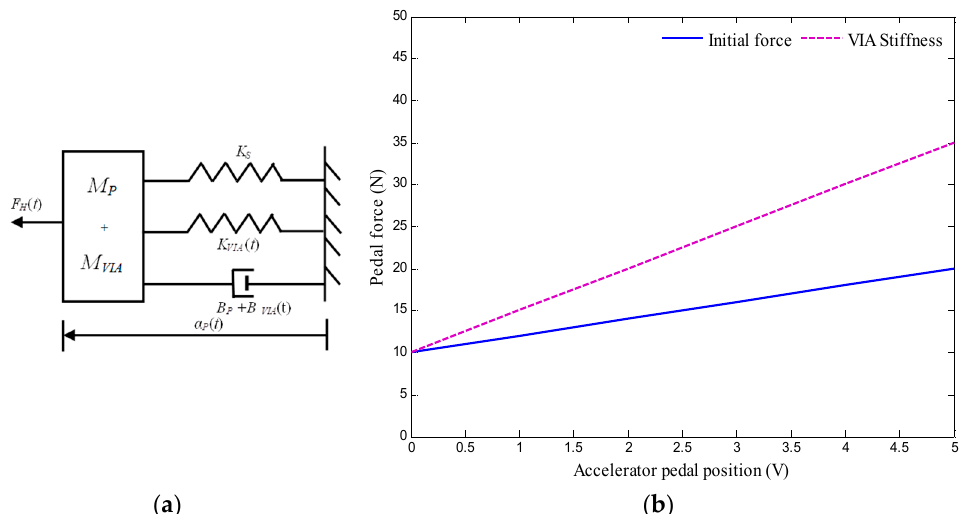
Figure 4. Mechanical model and characteristic; ( a ) schematic mechanical equivalent of the AAP dynamics with stiffness feedback, ( b ) position–force relationship of AAP with stiffness due to VIA.